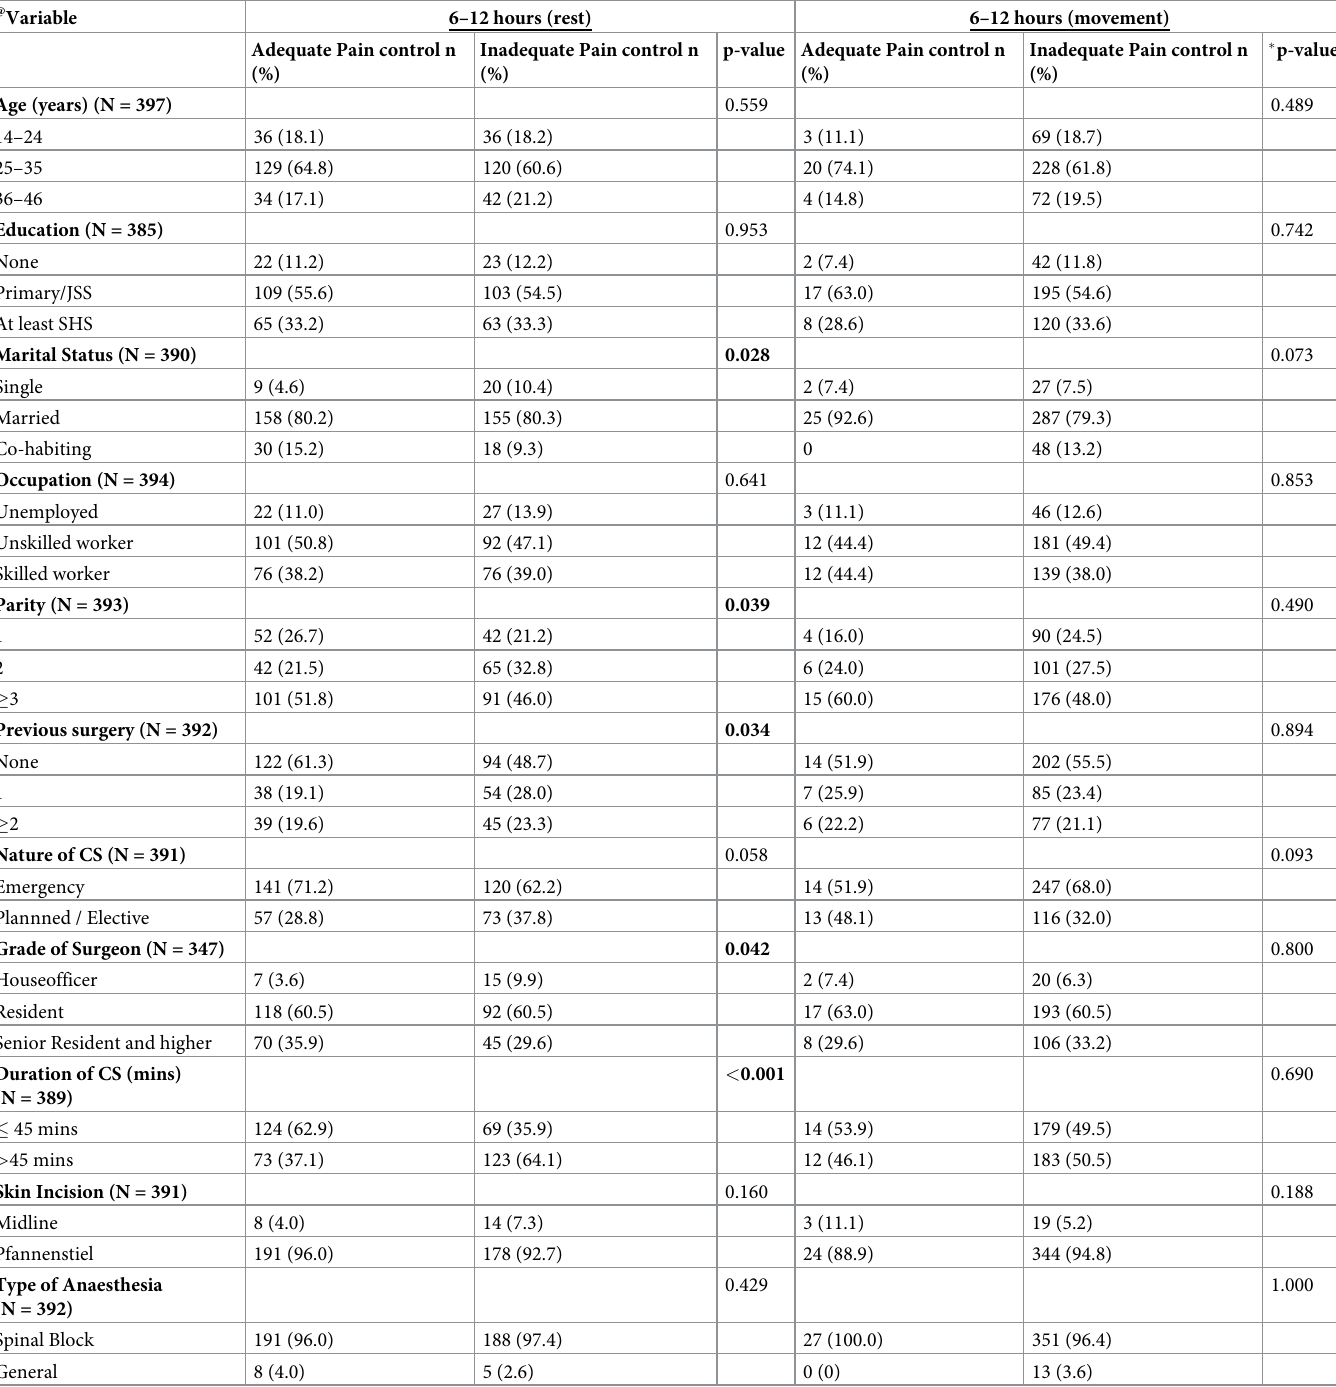
Table 3. Assessment of association between participants’ demographic and clinical characteristics and adequacy of pain control at 6–12 hours